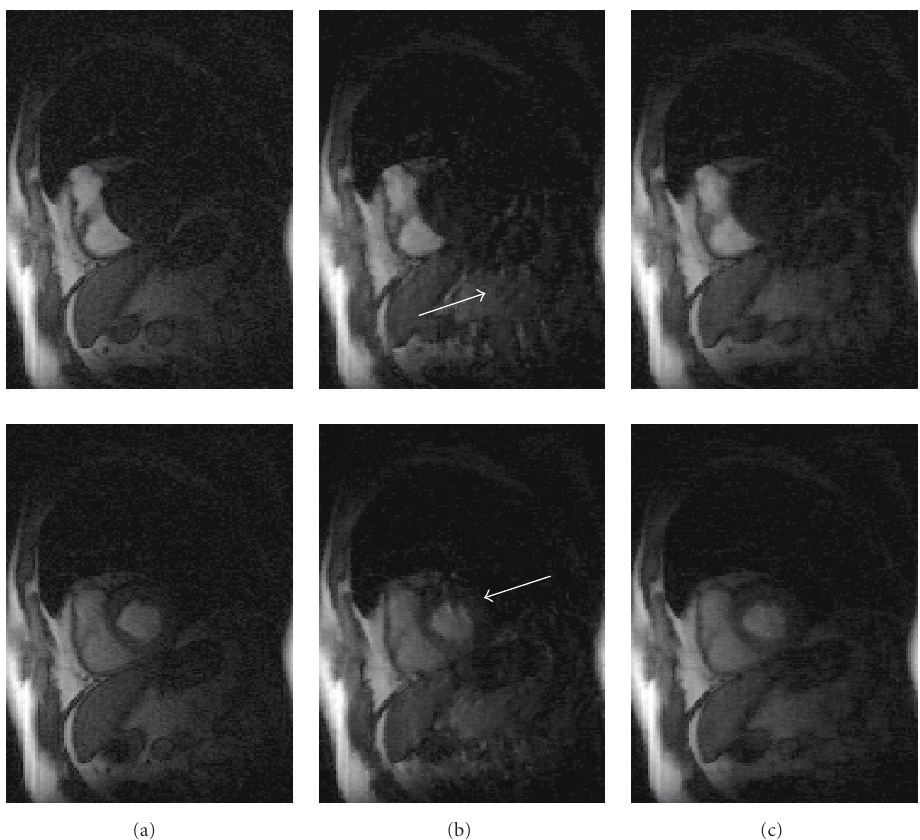
Figure 8: Result of multi-image reordering method on dynamic myocardial perfusion data. (a) Images at two di ff erent time points in the sequence reconstructed from full k -space data (first column). (b) Corresponding images reconstructed from R ∼ 2 . 5 k -space data, undersampled in variable density random fashion, using constrained reconstruction method in (4) but without any reordering (second column). The arrows point to the residual artifacts in the images. (c) Corresponding images reconstructed from R ∼ 2 . 5 k -space data using constrained reconstruction method in (4) with reordering (third